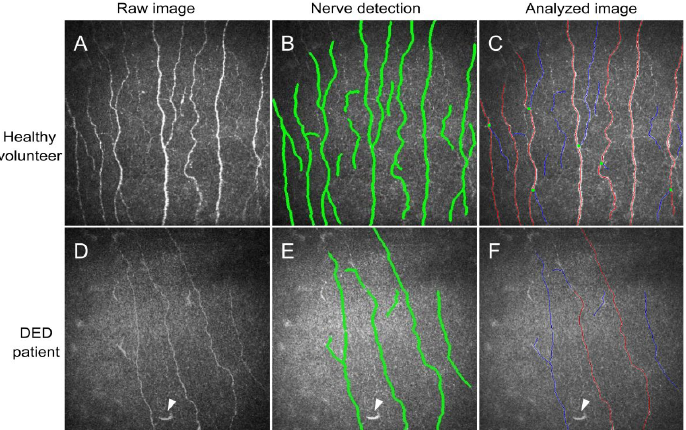
Figure 1. Examples IVCM image analysis using ACCMetrics © software. A, B and C show an image from a healthy cornea. D, E and F show the analysis process in the cornea of a DED patient. Note the differences in nerve fiber number and thickness between healthy (A) and DED (D) raw images (as obtained directly from the microscope). ACCMetrics © software detects nerve fibers (traces marked in green in B and E) automatically and segregates traces in primary axons (red), first branches (blue) and the points of branching (green dots) in the analyzed images for quantification(C and F). Arrowheads in D, E and F show one dendritic cell in DED patient images. The same images were also analyzed using the cell counter plugin of FIJI © image analysis software (ImageJ 1.53c: NIH, Bethesda, MD, USA) with the objective of quantify the incidence of neuromas (total number of neuromas per frame), beaded axons (count of the number of nerves which presented beaded axons per frame), and number of dendritic cells per frame of the central cornea. This part of the measurements was carried out in a semi-automatic way, in which the operator marked the presence of each of the